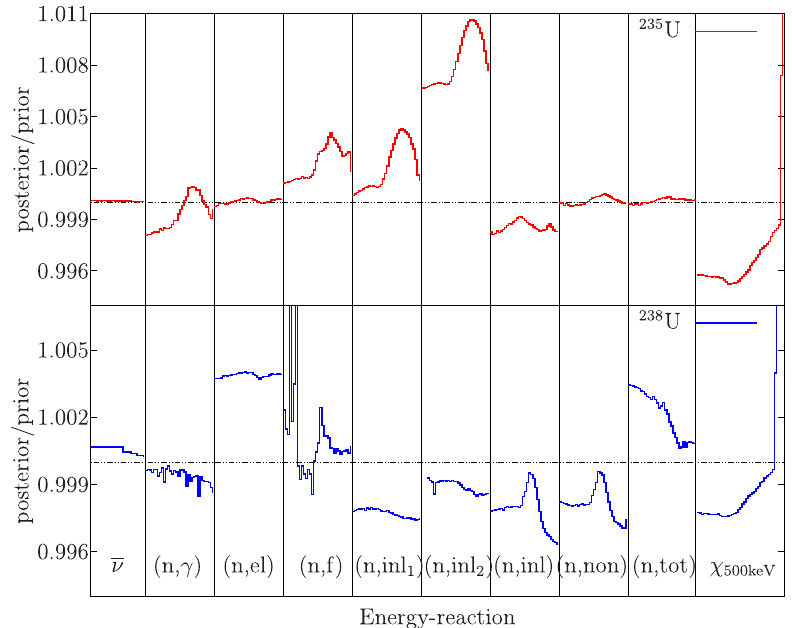
Fig. 9. Ratio of cross sections (and n and x ) for the post-adjusted ( a posteriori ) over the prior. The cross sections, n and x are presented from 100keV to 6 MeV on a logarithmic scale.